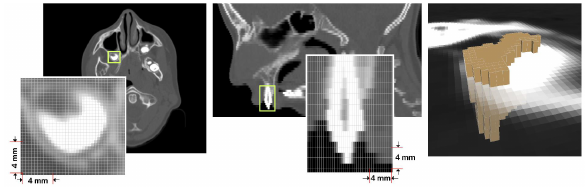
Figure 1. Tomographic image data: from pixels to voxels.